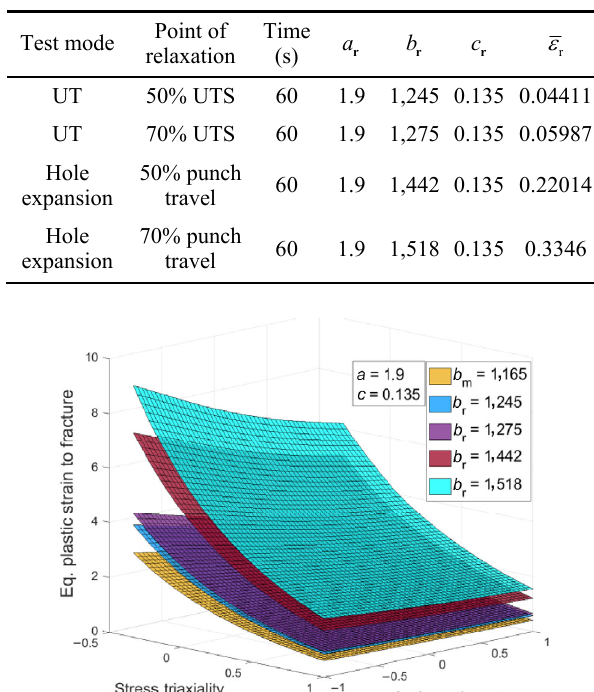
Table 2 Calibrated material parameters for modified HC fracture model.